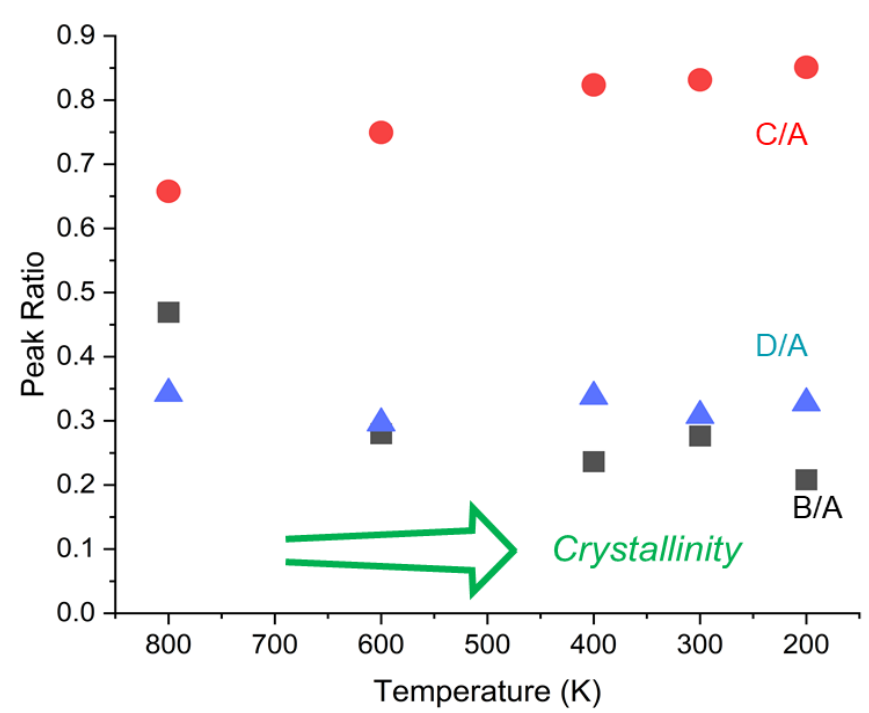
Figure 10. The ratio of peak areas as a function of temperature in the simulation. Area ratios of peaks B, C, D to peak A labeled same as experimental results (Figure 2).